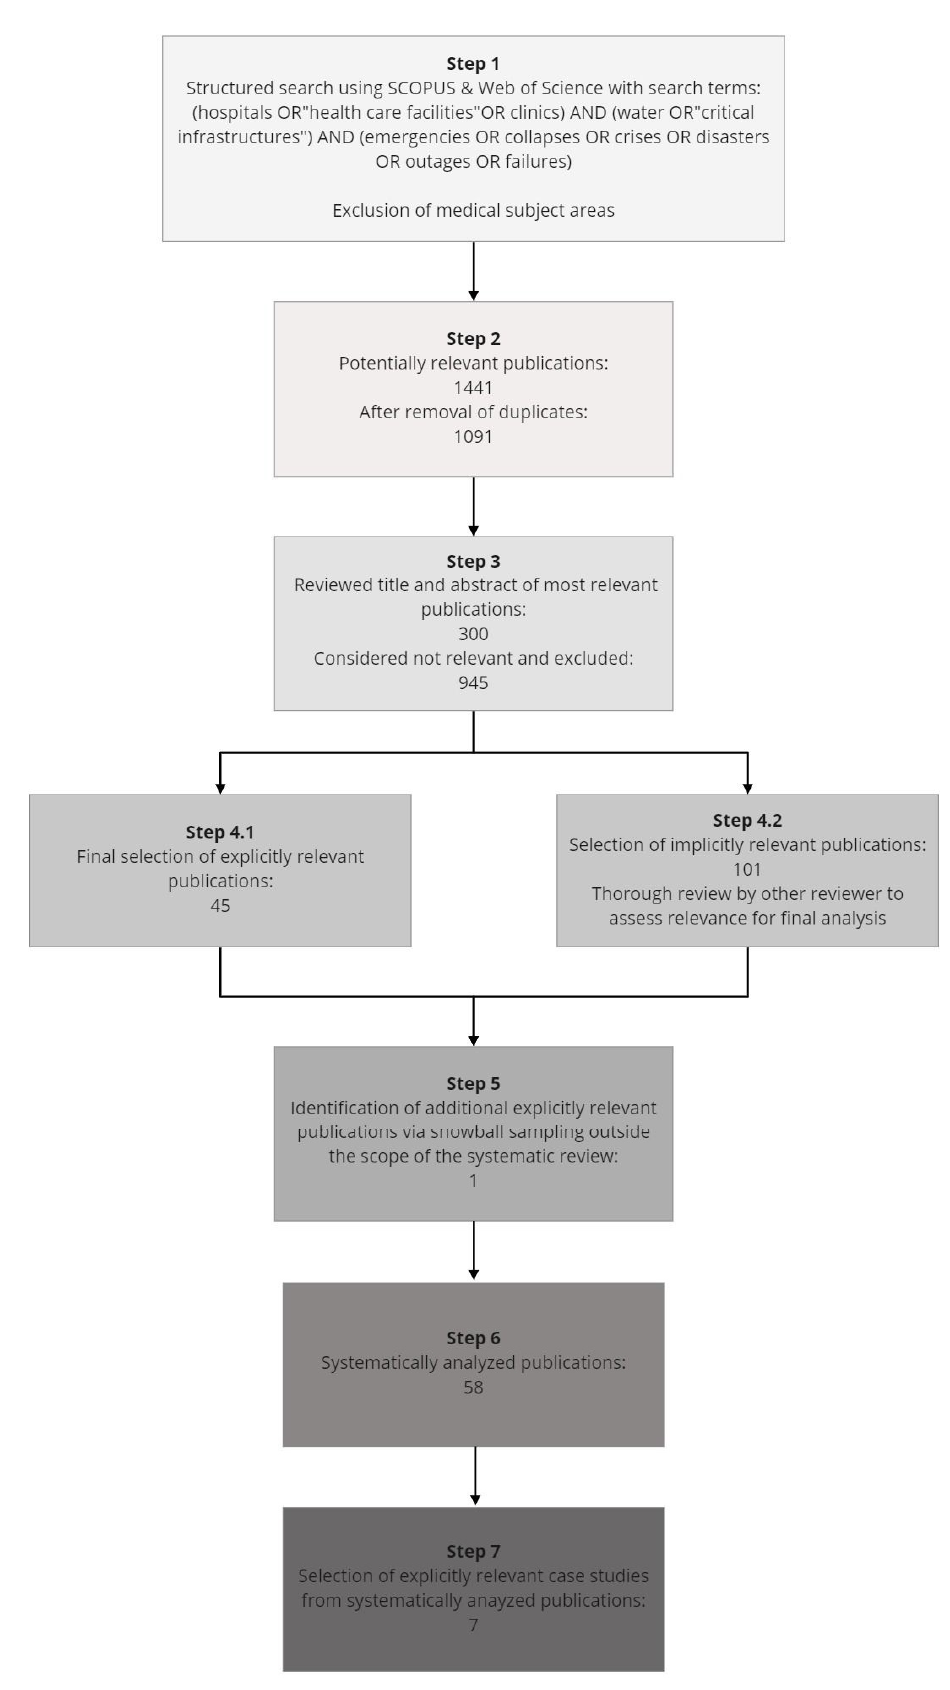
Figure 1. Visualization of the systematic literature review including all work steps and results.